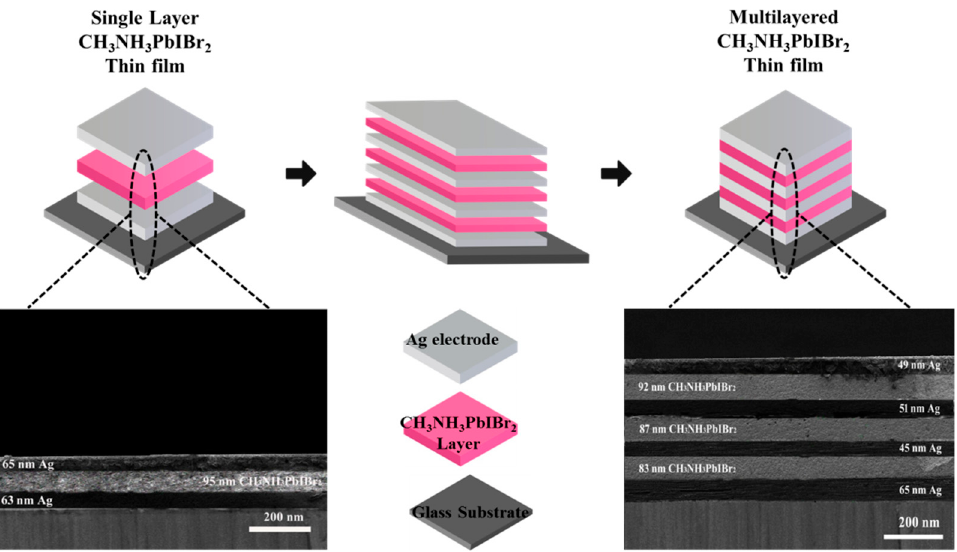
Figure 2. Schematic illustration of synthesized single-layer and multilayered CH 3 NH 3 PbIB 2 thin-films, along with the cross-sectional SEM images.